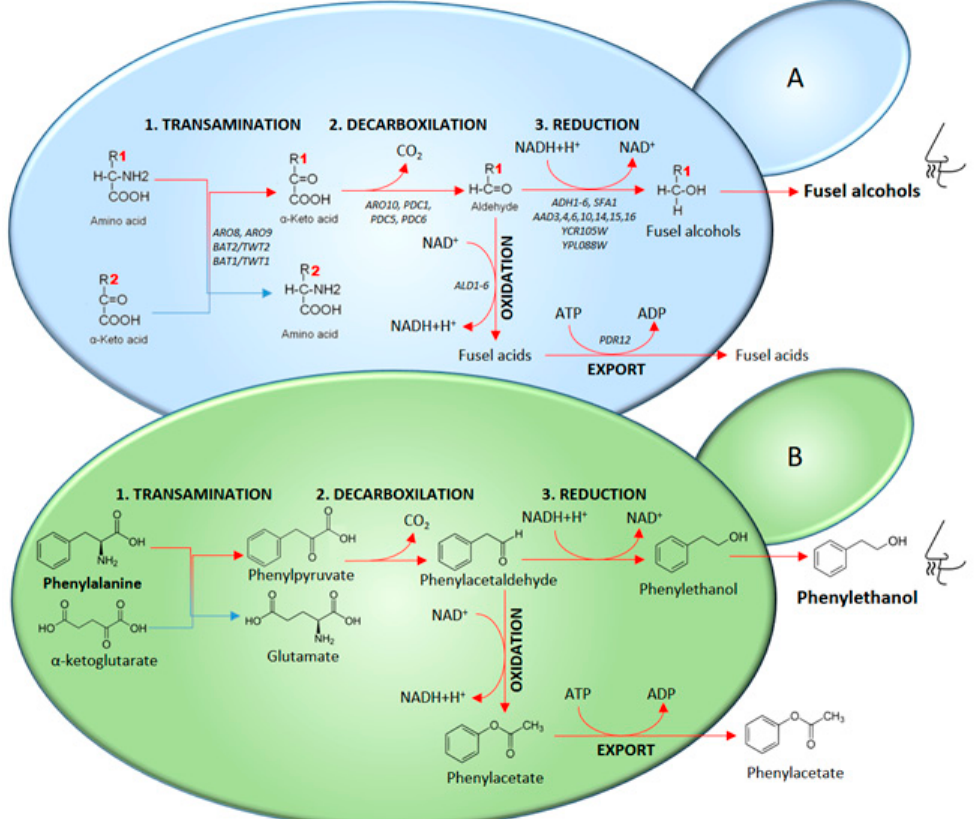
Figure 1. The Ehrlich pathway. Catabolism of aromatic amino acids (Phe, Tyr, and Trp), branched-chain amino acids (Leu, Val, and Ile) and sulphur-containing amino acids (Met) leads to the formation of fuse acids and fusel alcohols ( A ). Genes encoding enzymes involved in each step are shown. The catabolism of phenylalanine via the Ehrlich pathway leads to the formation of phenylethanol and phenylacetate ( B ).